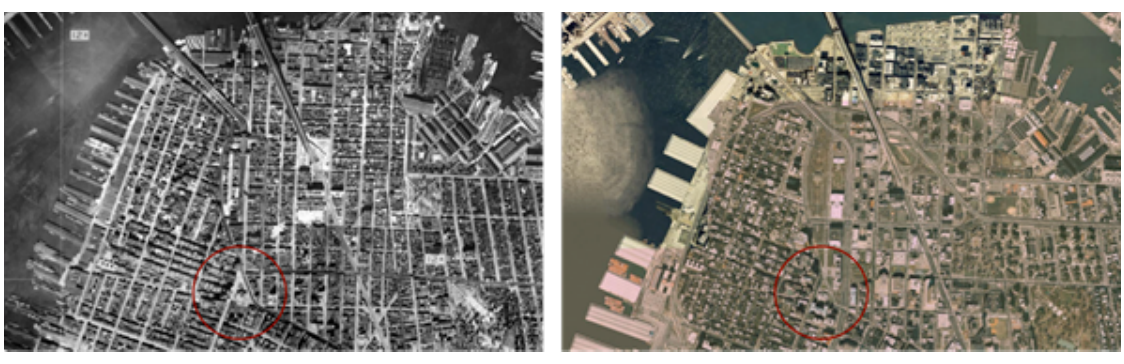
Figure 12. Left: 1924 aerial; right: 1996 aerial (Source: NYCityMap